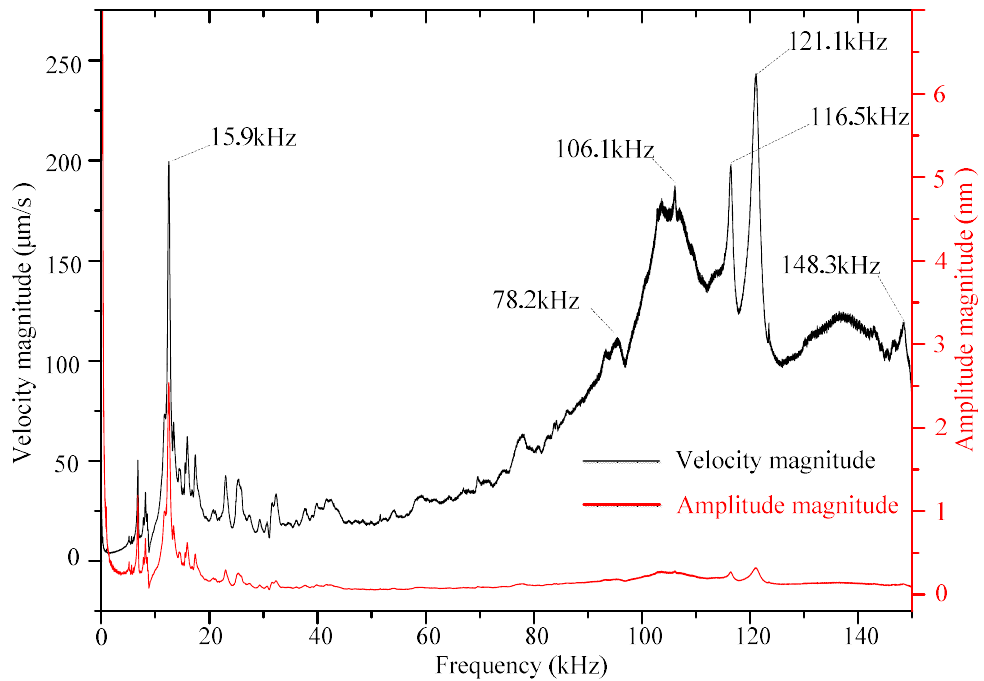
Figure 5. Frequency sweep curves of the vibration velocity and amplitude magnitude [29].